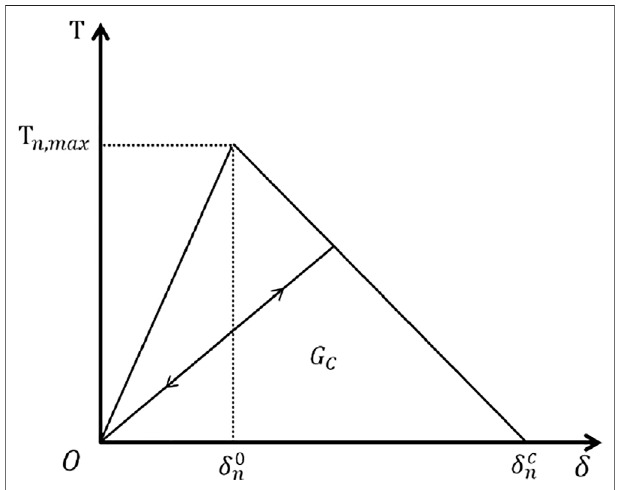
FIGURE 2 | Bilinear traction-separation law of the cohesive element.